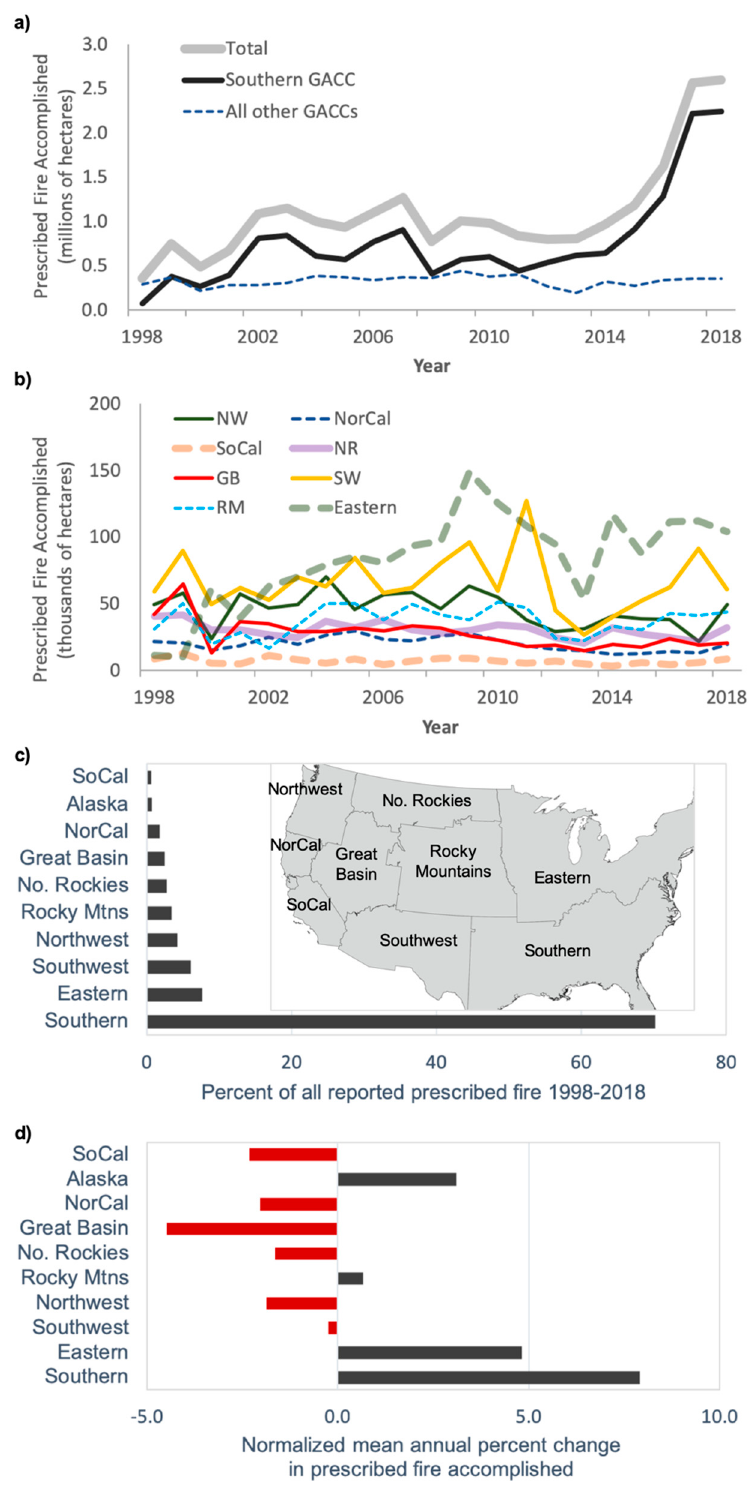
Figure 2. Prescribed fire accomplished in the United States (US) from 1998 to 2018 across Geographic Area Coordination Center (GACC) regions, including ( a ) total area burned (in millions of hectares), area burned in the Southern Geographic Area (GACC), and area burned in all nine other GACCs; ( b ) area burned (in thousands of hectares) in the eight other contiguous US GACCs (excludes Alaska and Southern); ( c ) proportion of all reported prescribed fire over the 21-year period by GACC; and ( d ) the normalized (by mean annual total accomplishment per GACC) mean annual change in prescribed fire completed, ranked by (c).